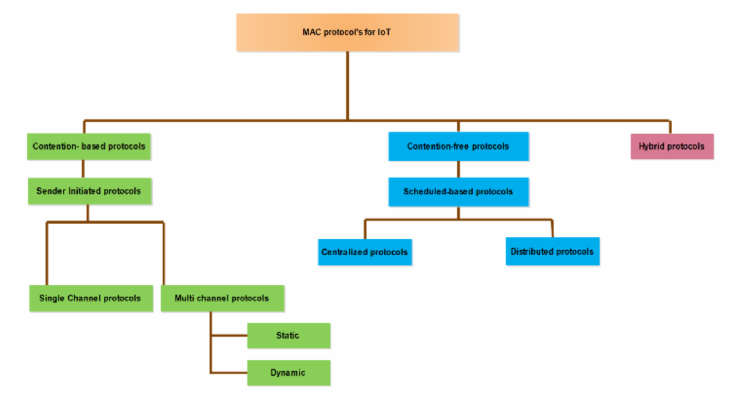
Figure 2. The proposed